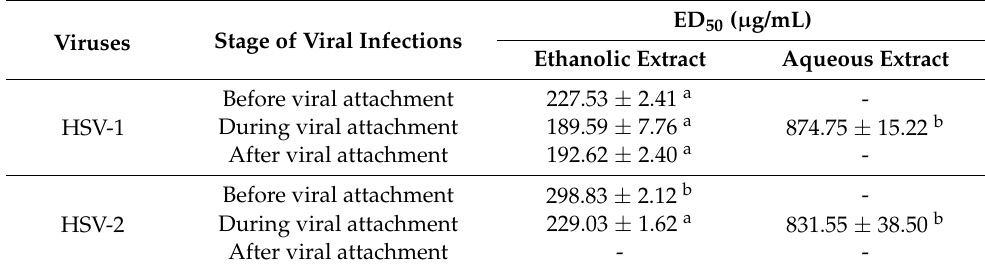
Table 4. Acyclovir (ACV) at ED 50 values of 1.72 and 2.83 µ g/mL was selected as a positive control to inhibit HSV-1 and HSV-2, respectively. Table 4. The 50% effective dose of ethanolic and aqueous extracts of red jasmine rice using plaque reduction assay.